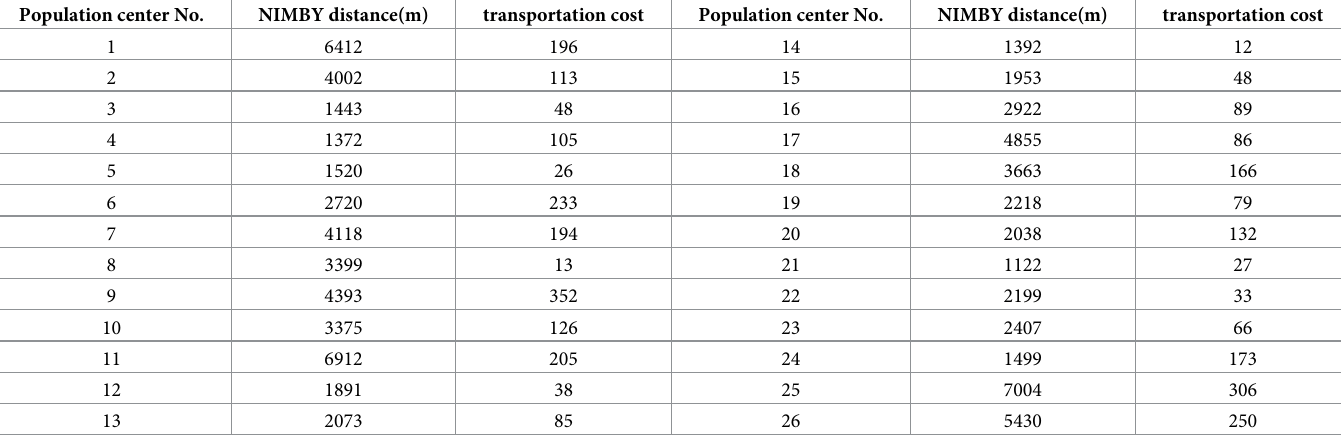
Table 5. The NIMBY distance and waste transportation cost of population centers in scheme #26 under Model 2. Population center